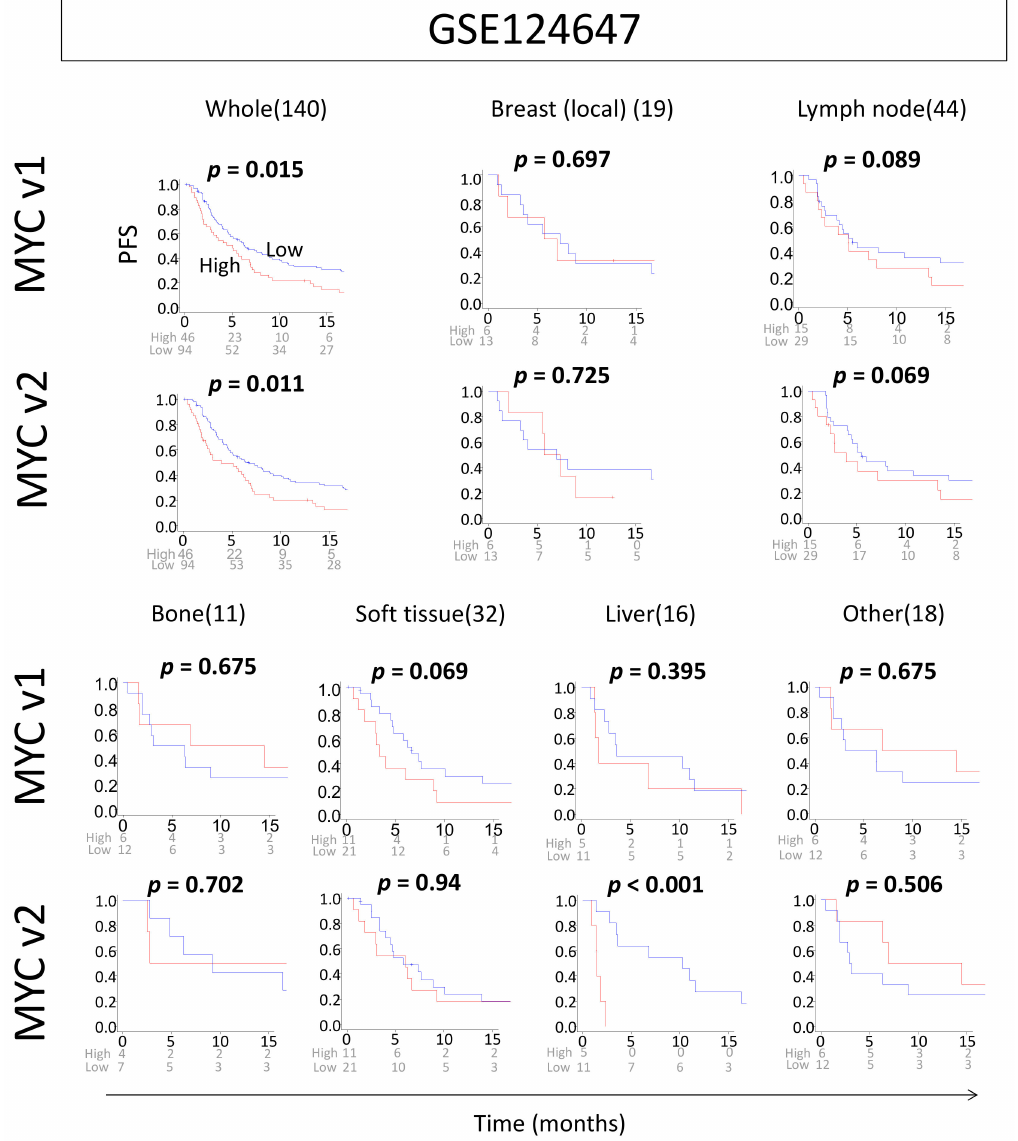
Figure 6. Progression-free survival (PFS) in metastatic breast cancer in high and low MYC targets v1 and v2 scores. Kaplan–Meier plots with log-rank test p -values showing PFS di ff erence between high- and low-MYC score groups in di ff erent locations of metastatic disease in the GSE124647 cohort. Number of patients are written next to the organ in